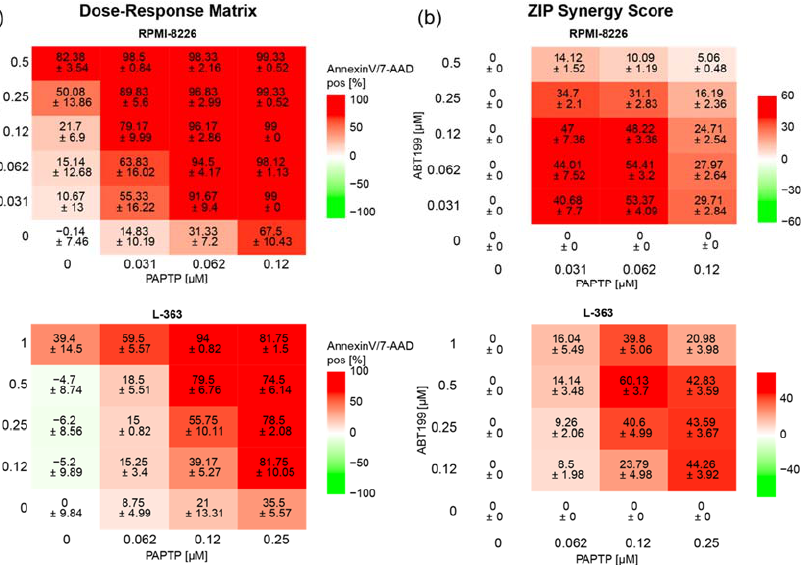
Figure 5. Combined treatment of multiple myeloma cell lines with PAPTP + ABT-199 improves killing compared to PAPTP alone. Cells were cultivated in the presence of different concentrations of PAPTP ± ABT-199 as indicated. After 24 h, cell death was analyzed by flow cytometry with Annexin V-APC/7AAD staining. ( a ) In the Dose–Response Matrix Annexin V/7AAD, positive cells are given in % normalized to solvent treated control. Shown is the mean ± SD, ( n = 3 independent experiments, each in duplicates). ( b ) Synergies were calculated using the onlinetool https://synergyfinder.fimm.fi accessed on 24 February 2022 [26] and expressed as zero interaction potency-score